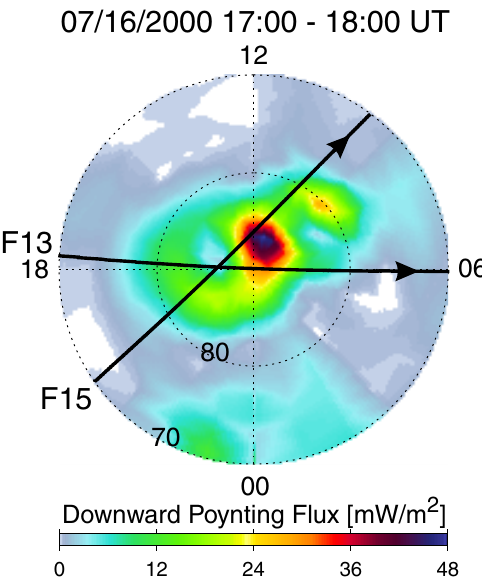
Fig. 8. The global distribution of the Iridium determined radial Poynting vector on 16 July 2000, from 17:00 UT to 18:00 UT in AACGM MLT-MLAT coordinates.